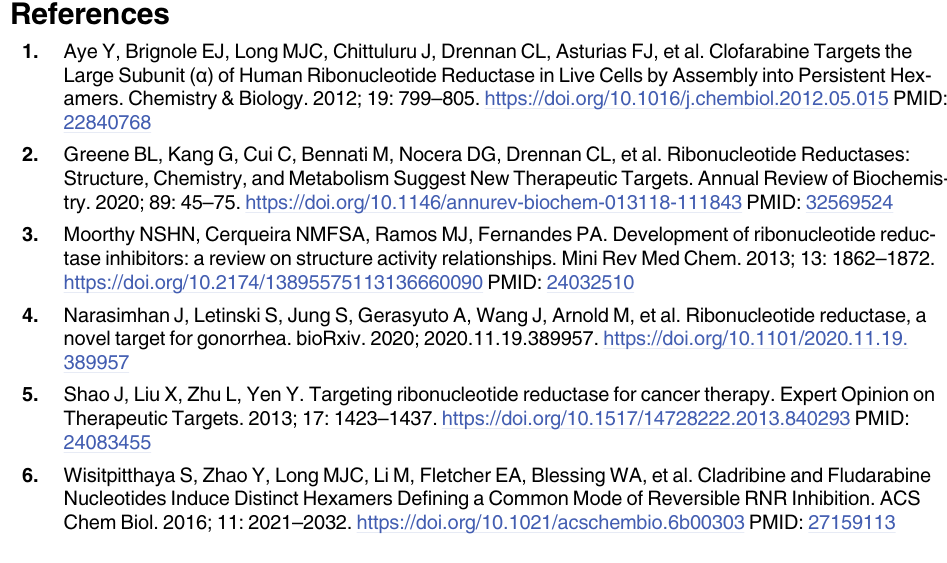
S7 Fig. EPR spectra of the glycyl radical in wild-type St NrdD. EPR parameters were 80K, 10 scans, modulation amplitude 3G, center field 3350 G, sweep width 200G, sweep time 21 s, microwave power